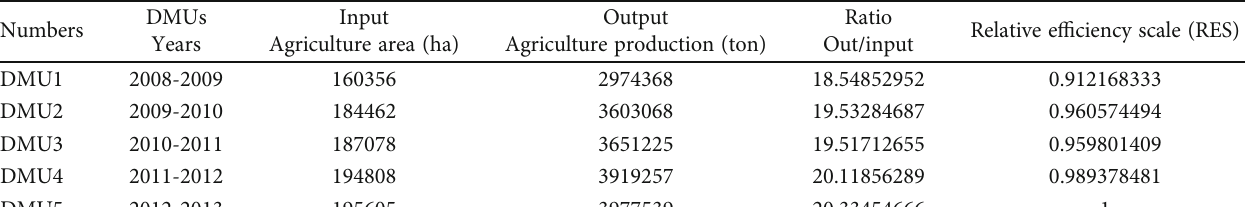
Table 1: One input and one output of fi ve-year KSA data of agricultural production (ton) and agricultural area (ha). Source (https://www .stats.gov.sa).